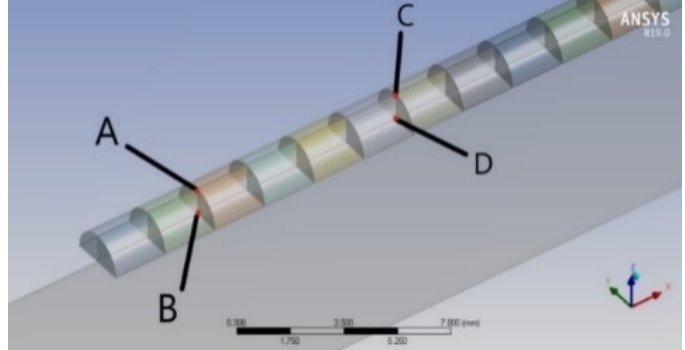
Figure 6. Monitoring points for 4 temperature probes.